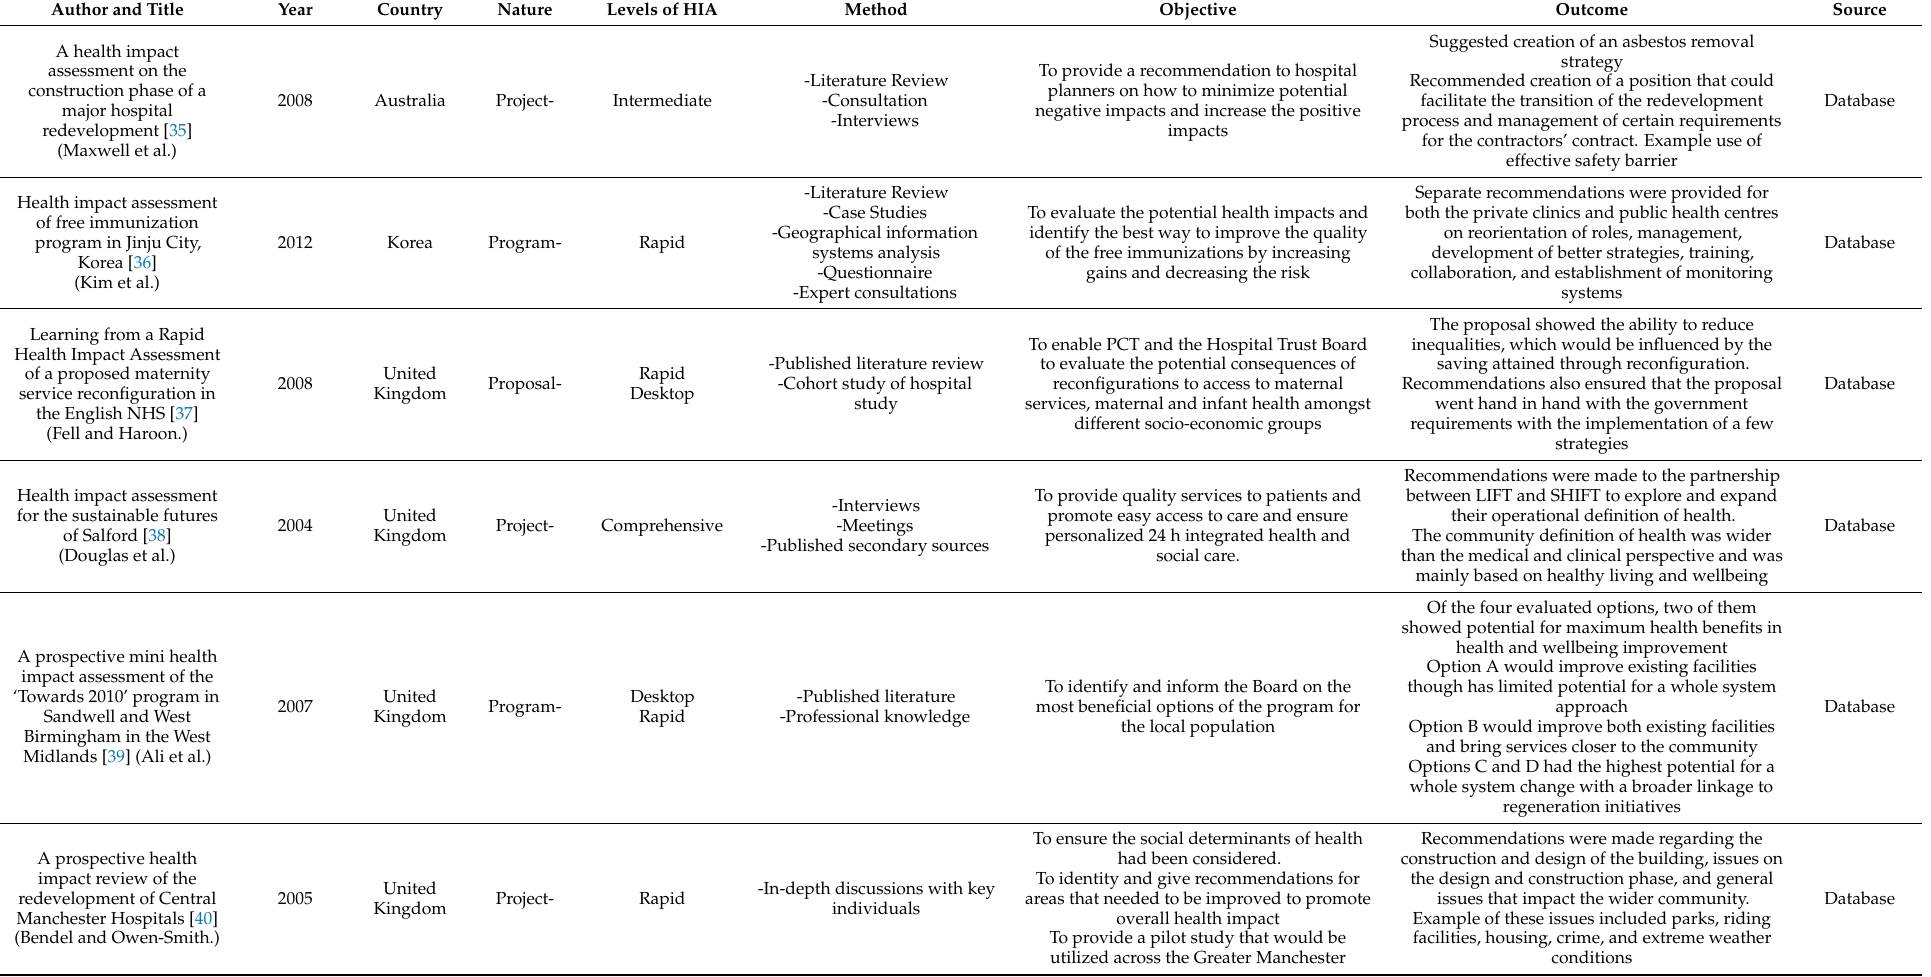
Table 1. Summary of included HIAs ( n =